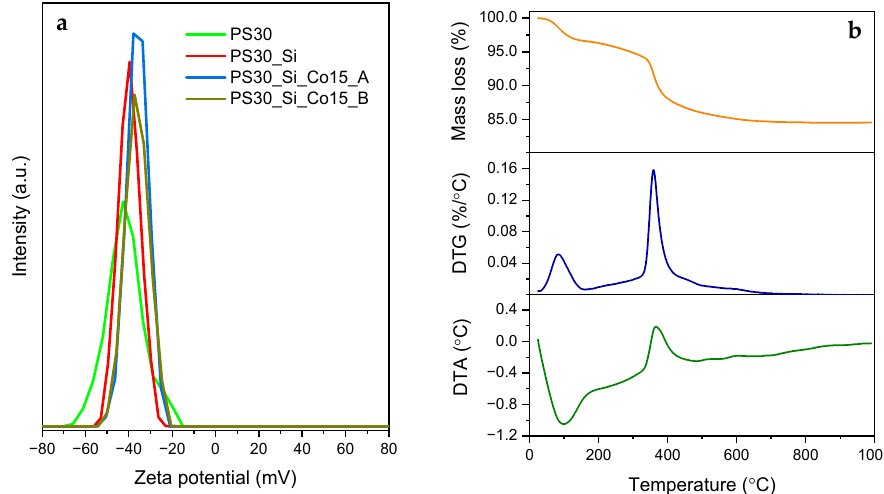
Figure 1. ( a ) Zeta potential distribution of samples dispersed in water, and ( b ) mass loss (TG), mass loss rate (DTG) as well as differential thermal analysis (DTA) curves for PS30_Si measured at air atmosphere.